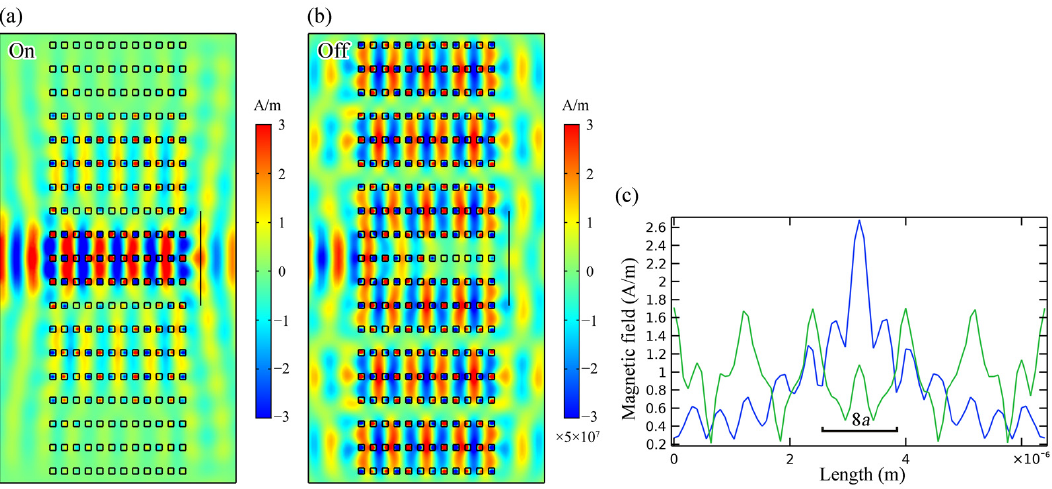
Figure 7. Nonlinear response of wave propagating in HMM PhC membranes as beam behavior changes from ( a ) collimation when | E | = 1 V/m (linear) to ( b ) divergence when | E | = 5 × 10 7 V/m (nonlinear). ( c ) Magnetic field profiles along the solid line in ( a ) and ( b ), showing in blue and green, respectively.